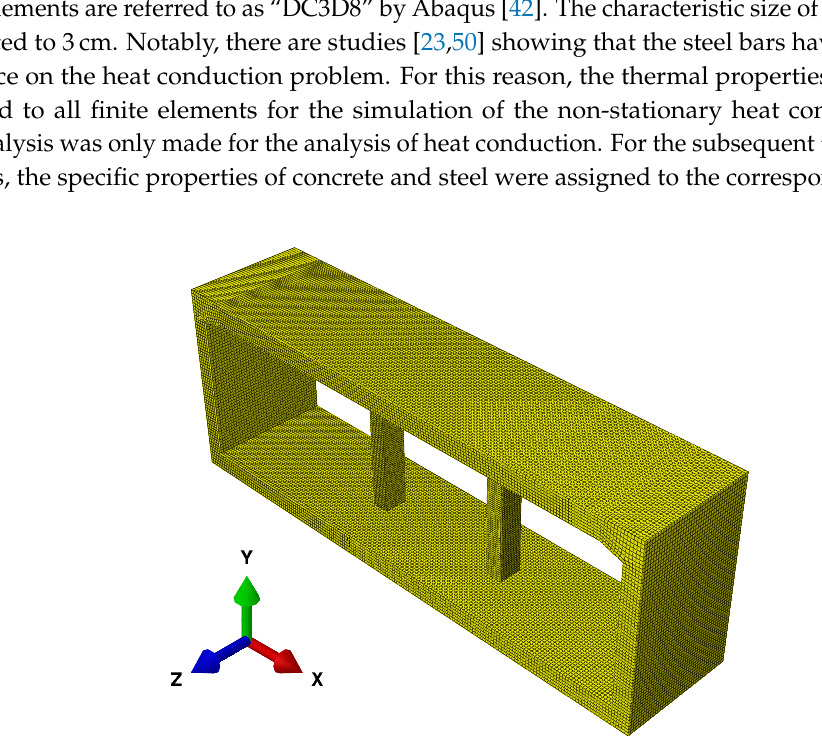
Figure 10. Three-dimensional Finite Element mesh of the analyzed structure and the Cartesian coordinate system